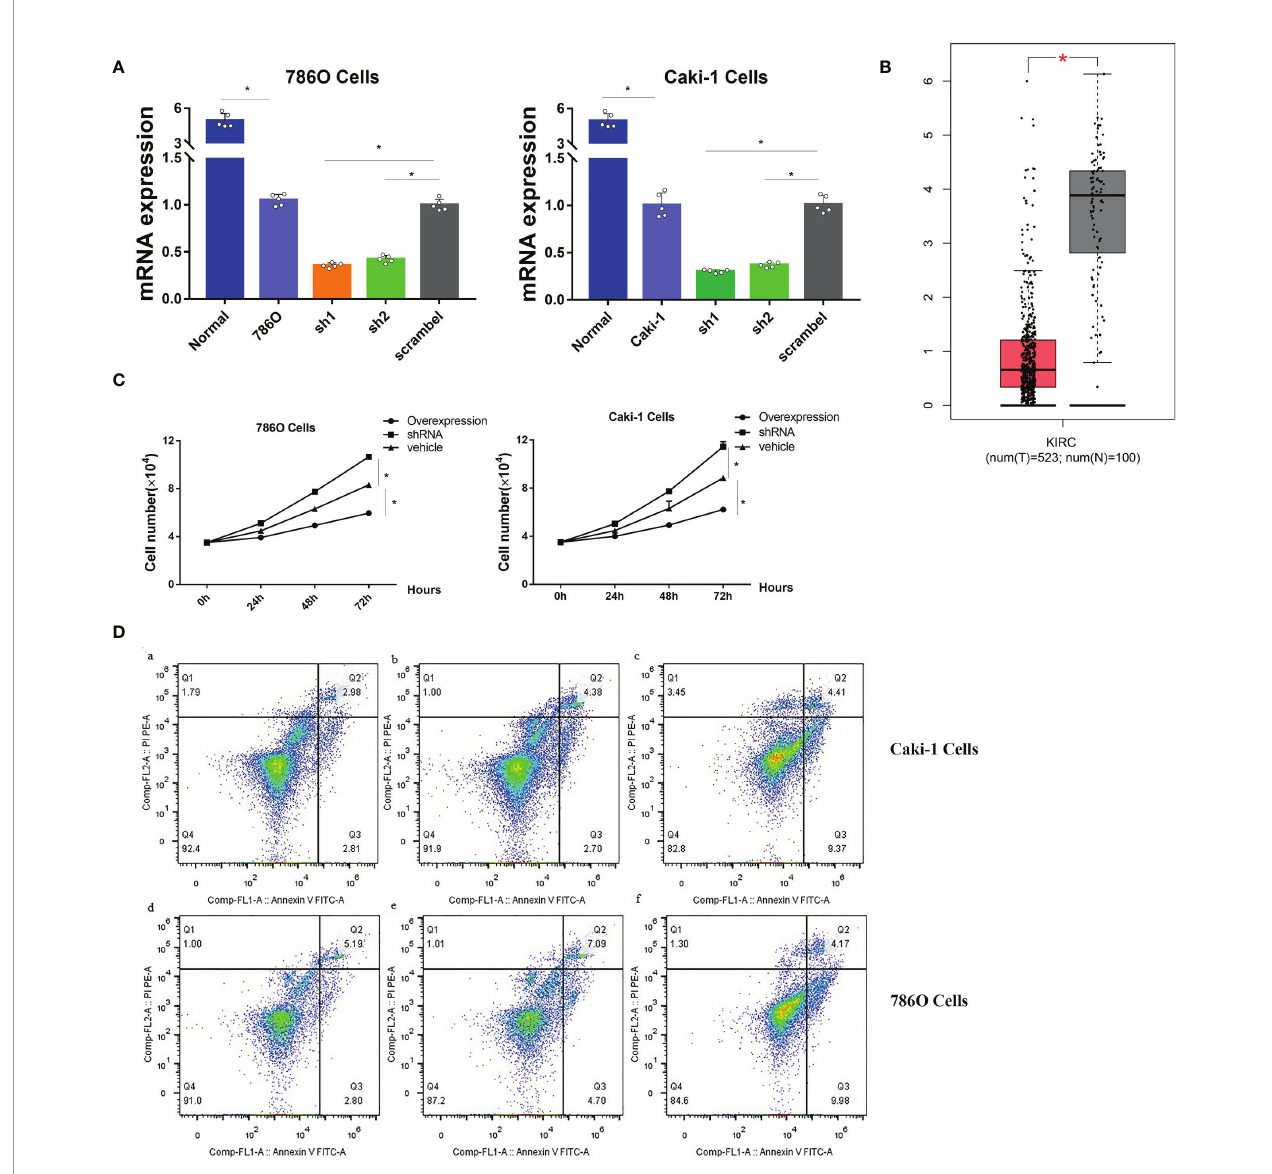
FIGURE 13 | (A) mRNA expression pro fi les of CHL1 in human normal kidney tissues, 786O/sh1/sh2/scramble cells and Caki-1/sh1/sh2/scramble cells. (B) mRNA expression pro fi les of CHL1 between normal tissues and tumor samples in the TCGA-KIRC cohorts with the online tool Gepia. Data represent mean ± s.e.m. Student ’ s t-test * P < 0.05 (two-tailed). (C) Proliferation of 786O/Caki-1 cells after CHL1 overexpression and knockdown. The total cell number was counted on days 0, 1, 2, and 3 after transfection. Data represent mean ± s.e.m. (n = 5 per group). One-way ANOVA with the Bonferroni correction for multiple testing, * P < 0.05. (D) Cell apoptosis was determined by fl ow cytometry in 786O/Caki-1 cells after transfection for 48 h. (a, d) , CHL1 knockdown group; (b, e) , vehicle group; (c, f) , CHL1 overexpression